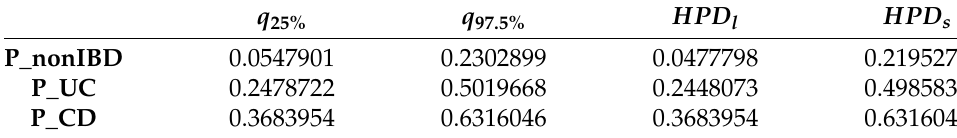
Table A2. 95% credible intervals: A_UC .